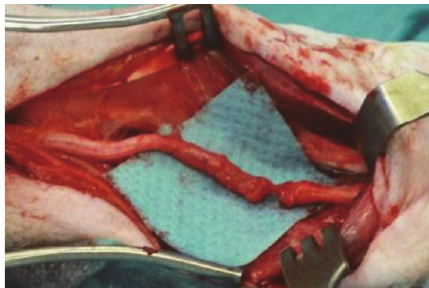
Figure 4: Complete transection of the tibial nerve in the midcalf area (intraoperative image).